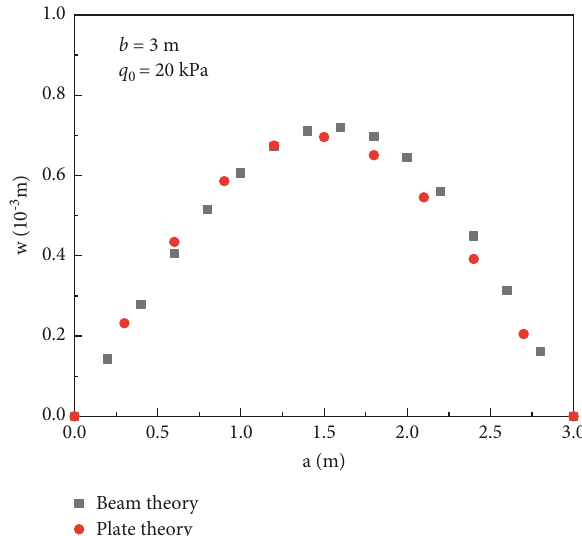
Figure 4: Deflection comparison between beam theory and plate theory.